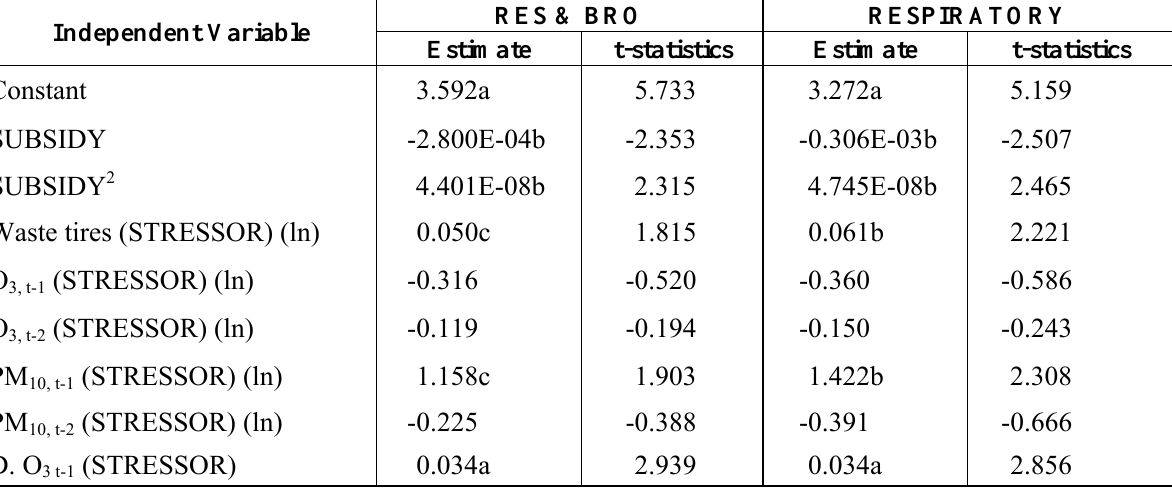
Table 2. Regression Results: Evaluation of Environmental Health Policy in Taiwan. Independent